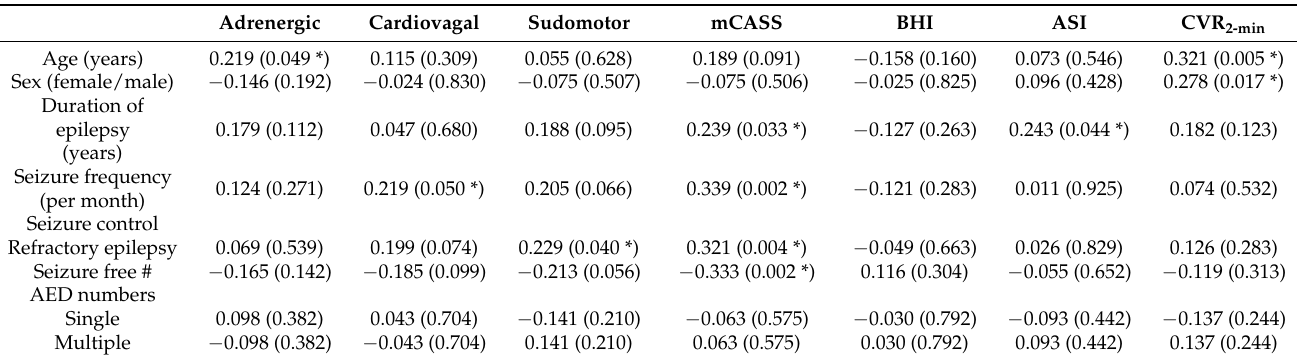
Table 4. Correlation analysis of autonomic function, cerebral autoregulation parameters, and demographic variables in patients with epilepsy and in the controls.